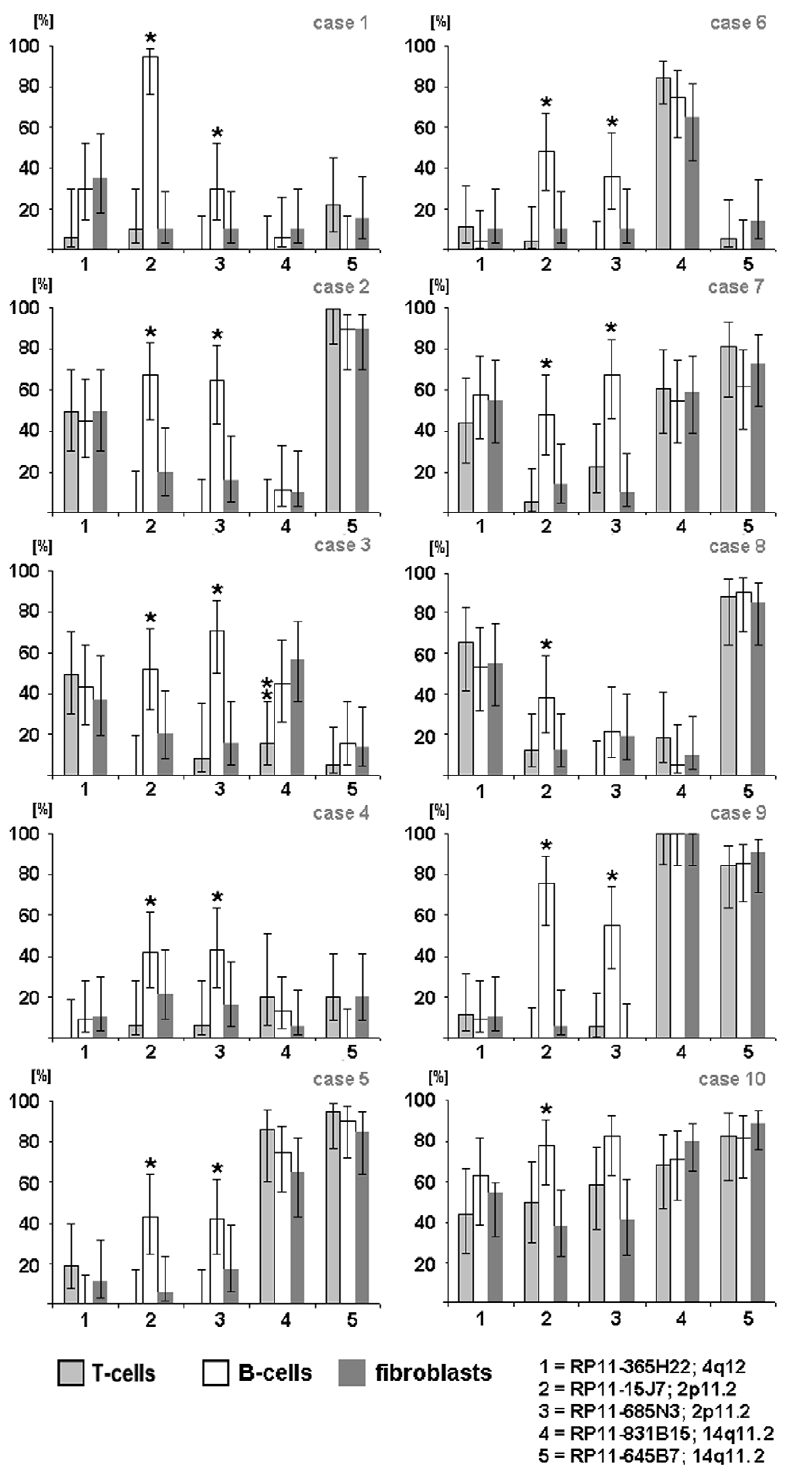
Figure 2. Varying signal intensity patterns of 5 selected CNV loci. Analysis of the signal intensity patterns of CNV at 2p11.2 (RP11-685N3: 88,981,161–89,122,3701bp; RP11-15J7: 88,979,594–89,141,7171bp), 4q12 (RP11-365H22: 52,354,875–52,530,859 bp), and 14q11.2 (RP11-645B7: 18,654,379–18,833,779 bp; RP11-831B15: 19,273,689–19,767,232 bp) in three cell types, each, from 10 different individuals. Notes: (1) X axis: BAC probes; Y axis: [%] = percentage of cells with different signal intensities. (2) In diagrams with no columns, no cells with different signal intensities for the BAC probes were detected. Abbreviations: T cells (= metaphases from T lymphocytes collected after PHA stimulation of the peripheral blood), B cells (= Epstein–Barr-virus-immortalized B-lymphoblastoid cell lines from the peripheral blood), and fibroblasts (= metaphases from skin biopsies). * Statistically significant difference (B cells vs T cells and B cells vs fibroblasts, P , 0.05). ** Statistically significant difference (T cells vs B cells and T cells vs fibroblasts, P , 0.017).